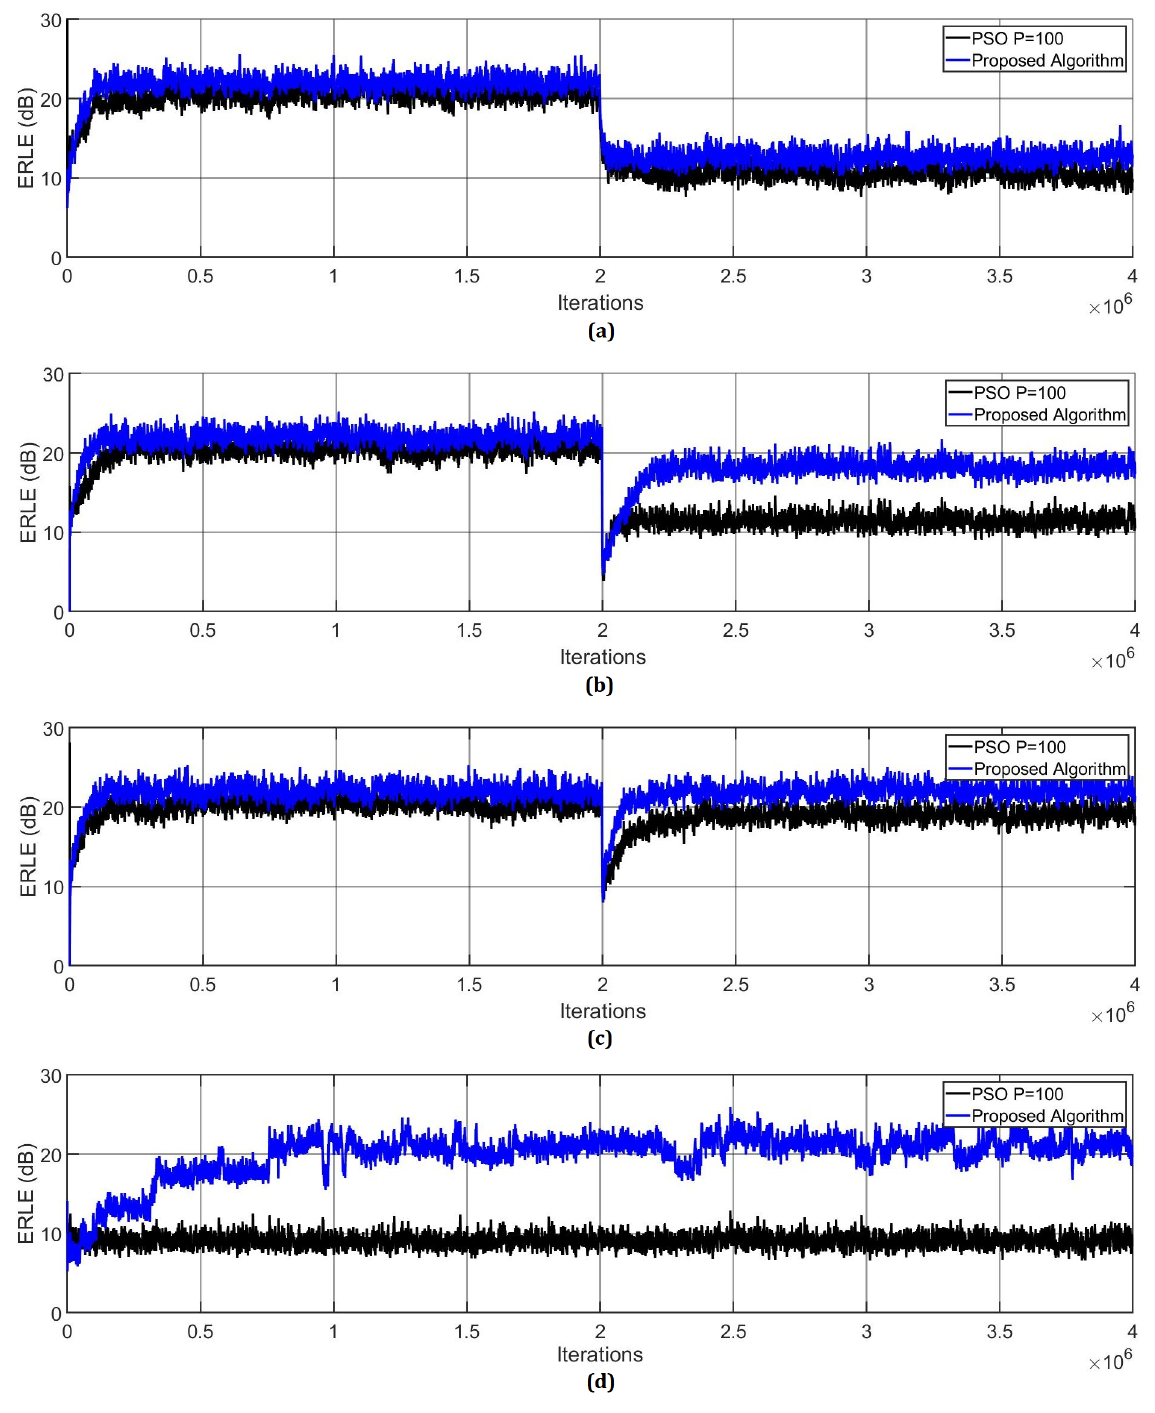
Figure 5. ERLE of the proposed Markov switching PSO algorithm and conventional PSO algorithms by computing the AR(1) process input signal. ( a ) Changing the SNR from 20 dB to 10 dB at the middle of the iterations. ( b ) Multiplying the acoustic path by − 1 in the middle of the adaptive filtering process. ( c ) Shifting the acoustic path in the middle of the adaptive filtering process. ( d ) Simulating the double-talk